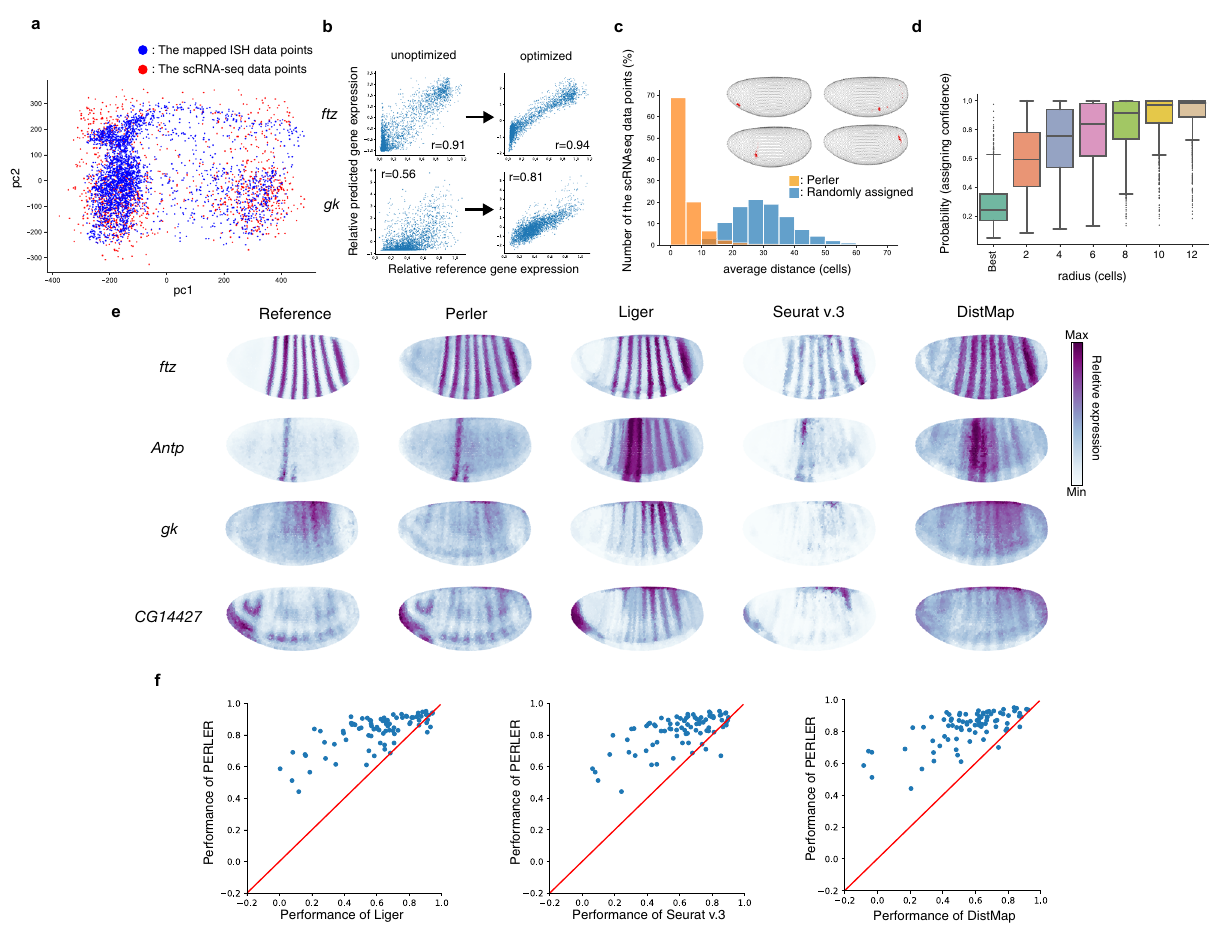
Fig. 2 Generation of spatial gene-expression pro fi les. a Scatter plot of mapped gene expression and scRNA-seq observations (Fig. 1b, upper right panel). Principal component analysis 13 was used to visualize high-dimensional gene-expression data into two dimensions. b Improved correlation between predicted and referenced data in the scRNA-seq space by optimizing the weighting function. c Histogram of the assigned speci fi city evaluated by the distance between the best assigned location and the following best three locations. The distance was calculated by mean path length on the k -NN graph comprising all cells in the tissue ( k = 6). Examples of estimated original positions of each scRNA-seq data point (inset). Embryos are colored according to the posterior probabilities for the scRNA-seq data points. Point sizes indicate the magnitude of each posterior probability. Points with posterior probabilities <0.001 were omitted. d Boxplot of the assigned speci fi city calculated as the posterior probabilities of circular regions for each scRNA-seq data point according to radius, with the center of each region representing the best assigned location for each data point. For the box signi fi es the upper and lower quartiles, and the median is represented by a short black line within the box. The boxplot has whiskers with a maximum 1.5 interquartile range, with black points indicating outliers. The radius was calculated by path length on the k -NN graph comprising all cells in the tissue. n = 1297 biologically independent cells (scRNA-seq data points). e Reconstructions of the landmark genes by Perler, Liger, Seurat (v.3), and DistMap. f Comparison of Perler reconstruction performance with Liger (left, two-sided Wilcoxon test: p = 1.8 × 10 − 14 ), Seurat (v.3) (middle, two-sided Wilcoxon test: p = 2.5 × 10 − 14 ), and DistMap (right, two-sided Wilcoxon test: p = 2.9 × 10 − 15 ). Each dot indicates the reconstruction accuracies for each gene by Perler and other methods. Red lines depict auxiliary lines showing the same performance of two methods. Source data are provided in a Source data fi